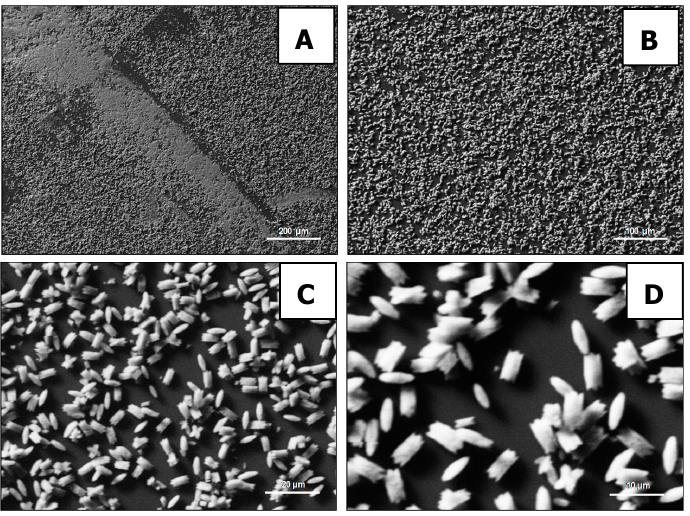
Figure 4. SEM images of CaOx crystals grown on PS films sulphonated and diazotated with 2-trifluoromethyl aniline. Low ( A , B ) and high ( C , D ) magnifications.